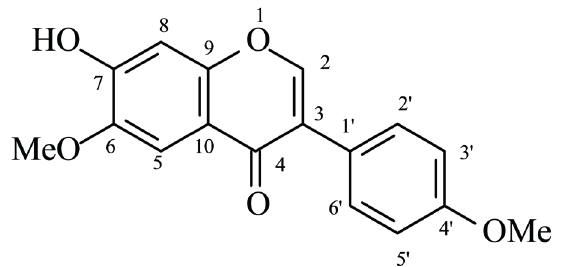
Figure 1 - Chemical structure of the 7-hydroxy-4’, 6-dimethoxy-isoflavone isolated from the ethanol extract of Myroxylon peruiferum l.f bark.